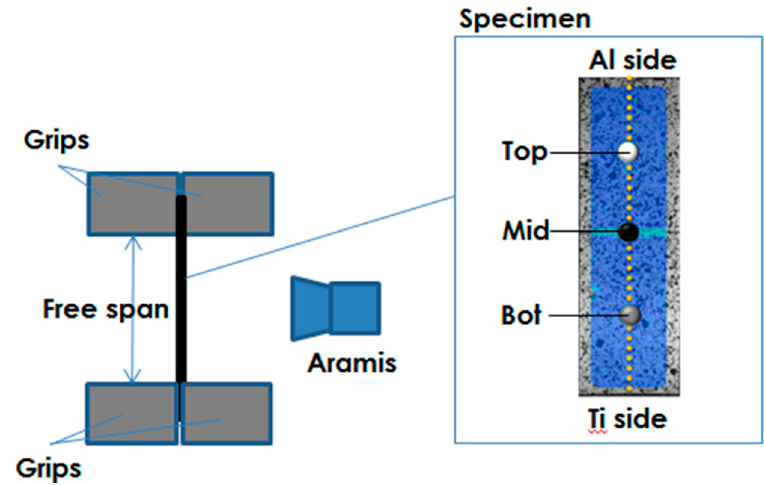
Figure 9. Scheme of the set-up adopted for the tensile test.